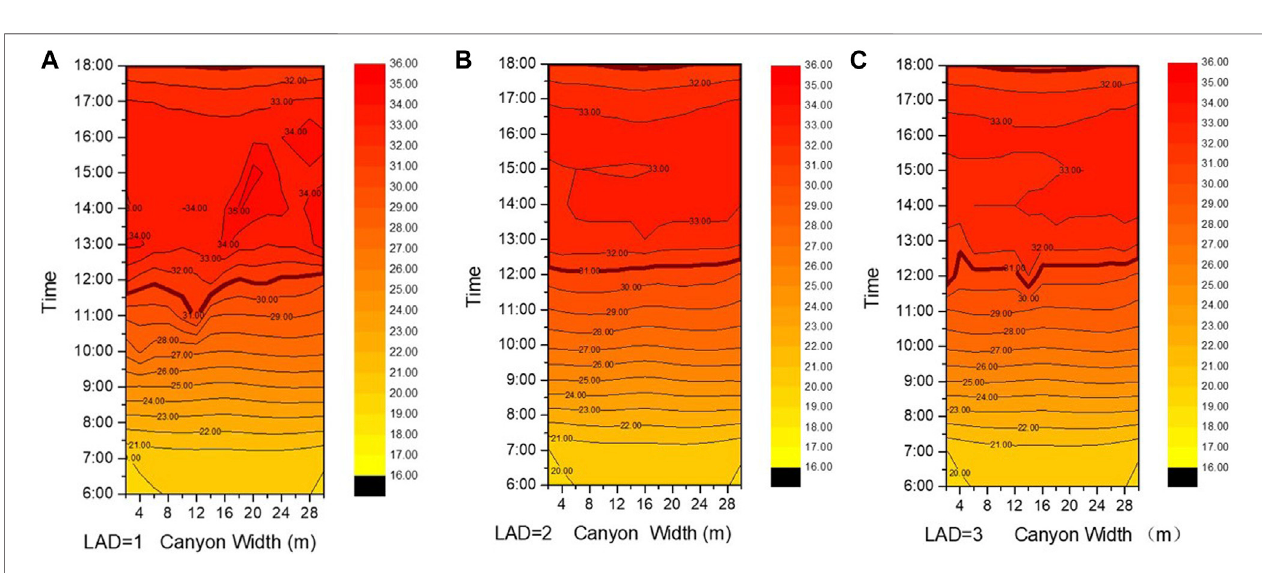
FIGURE 11 | Temporal and spacial variations in PET at the pedestrian level within the street canyons in different LAD-LAD = 1 (A) , LAD = 2 (B) and LAD = 3 (C) .